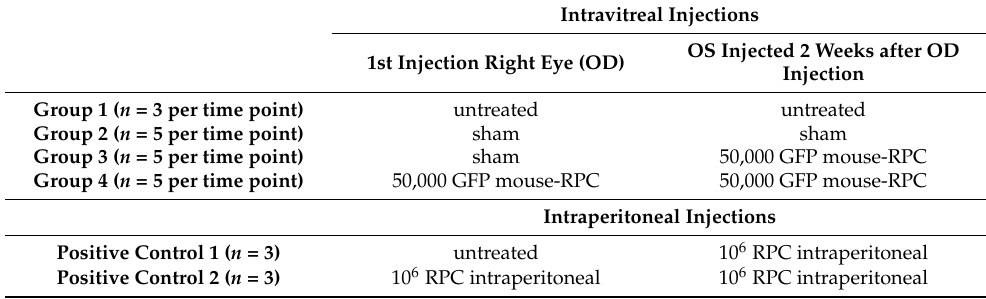
Table 1. Experimental groups.